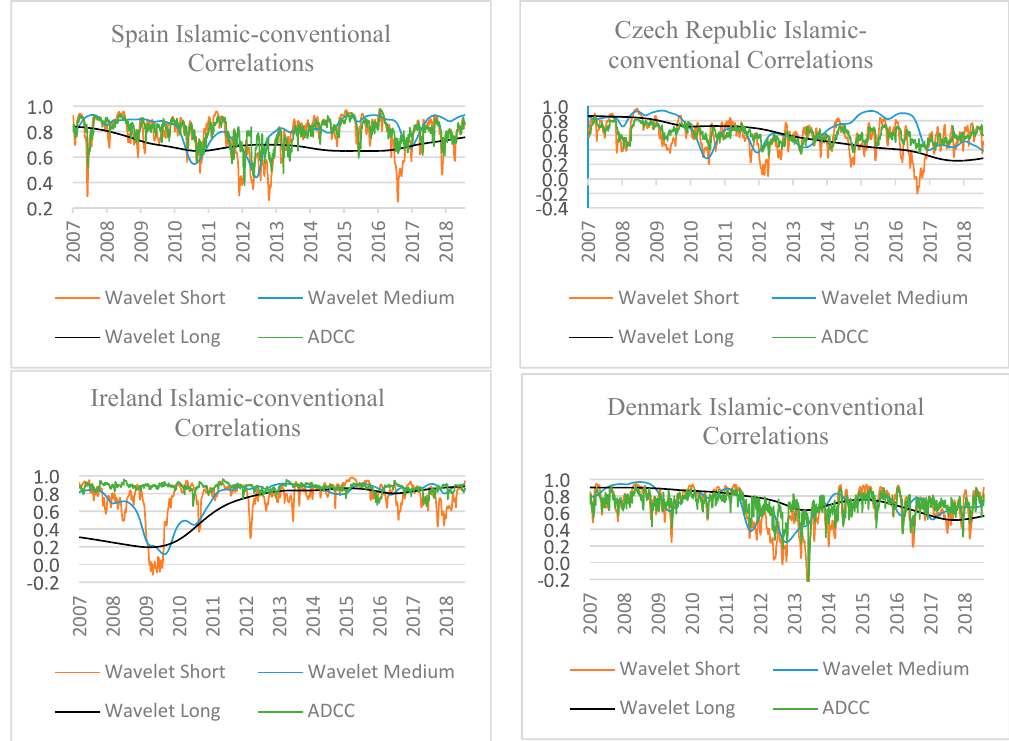
Figure 5. Wavelet short-, medium-, long-term and ADCC correlations for European Islamic and conventional equity markets.